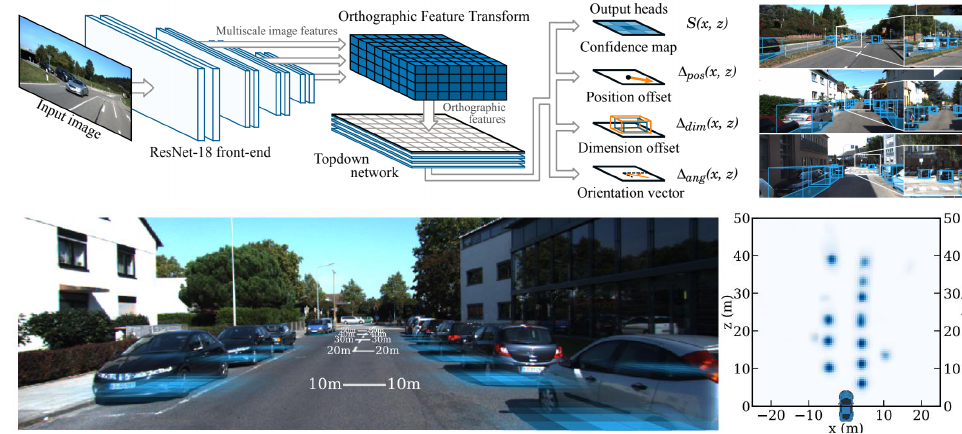
Figure 8. Architecture overview for the orthographic feature transform